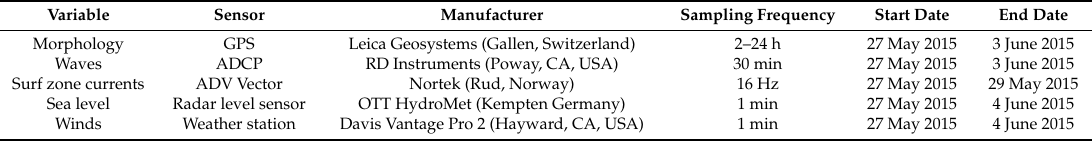
Table 1. Measured data, sensor employed, sampling frequency and measured